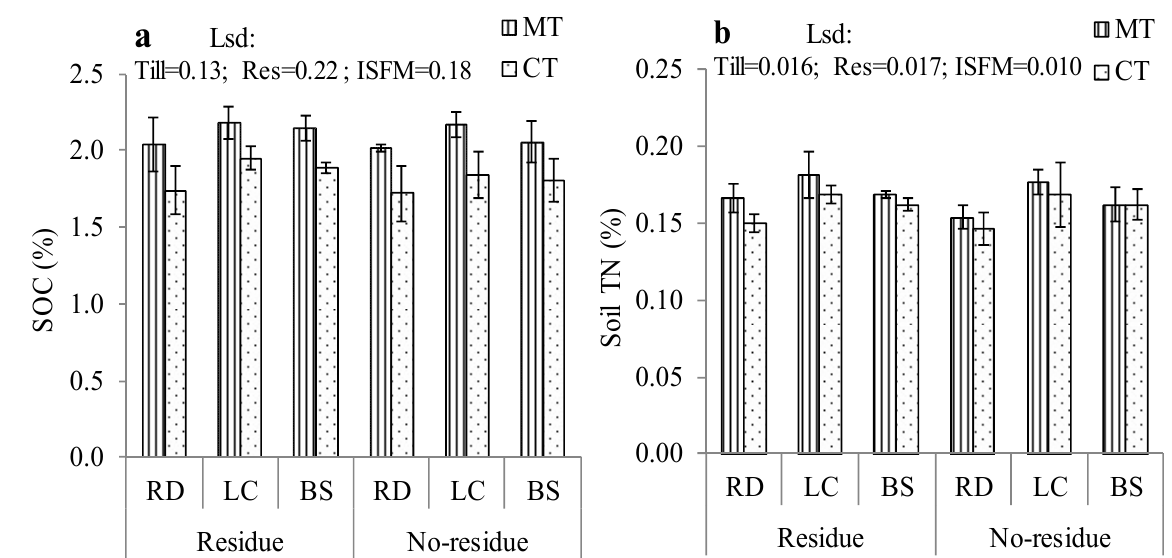
Figure 6. Post-harvest soil organic carbon (SOC) and TN contents after two consecutive years ( a ) 2017 and ( b ) 2018 of ISFM with crop residue and tillage practices management impacts on post-harvest soil.